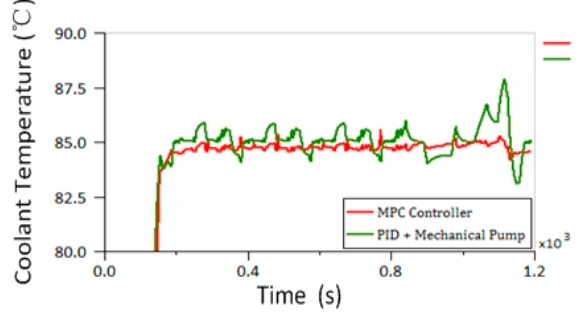
Figure 17. Comparison of the coolant temperature.